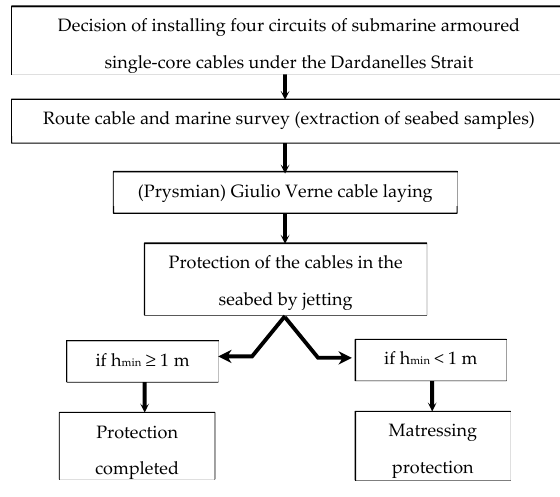
Figure 16. Flow-chart of the installation steps.